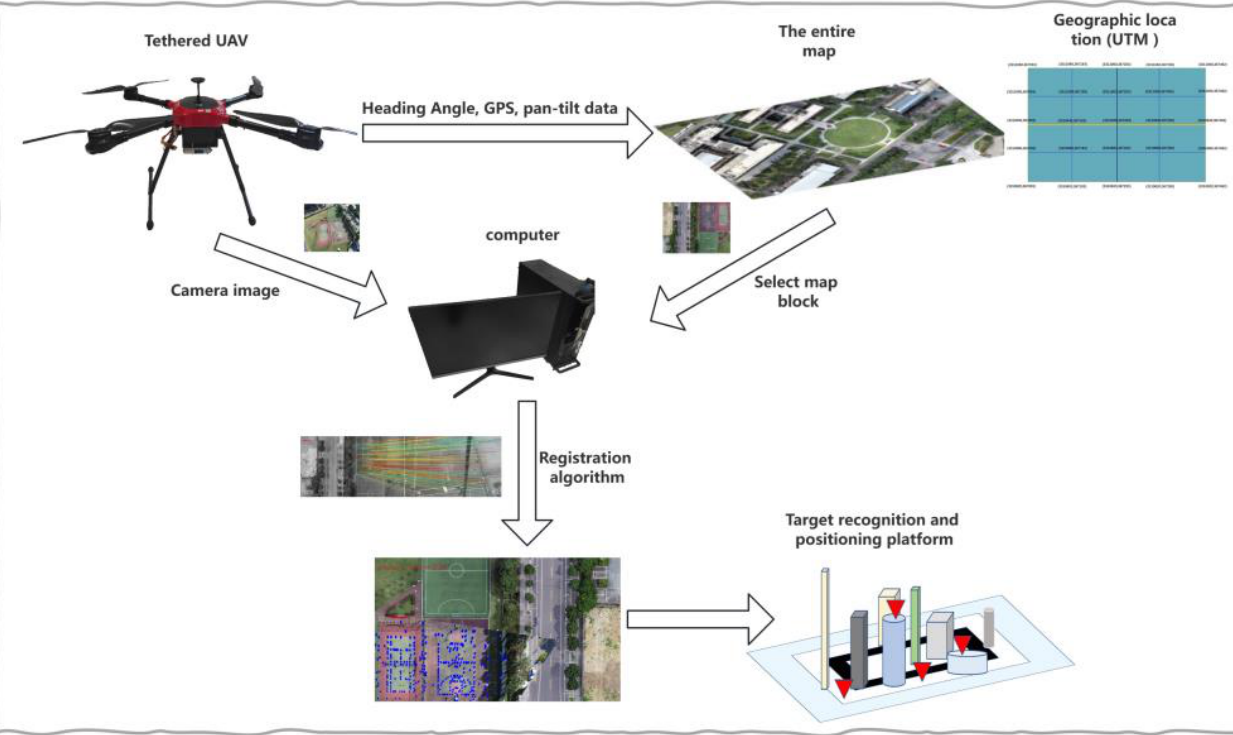
Figure 1. System functional architecture.